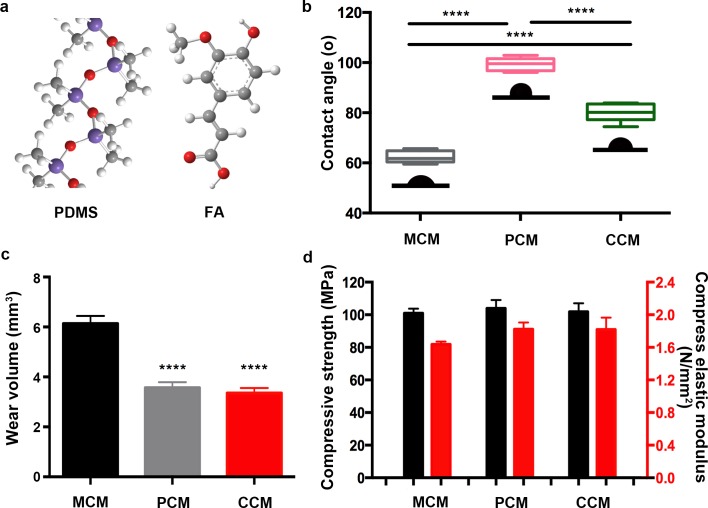
The physical characterization of MCM, PCM and CCM.(a) The chemical formula of PDMS and FA. (b) Material hydrophilicity test, (c) Wear volume and (d) Mechanical properties of MCM, PCM and CCM. ****: P<0.0001.